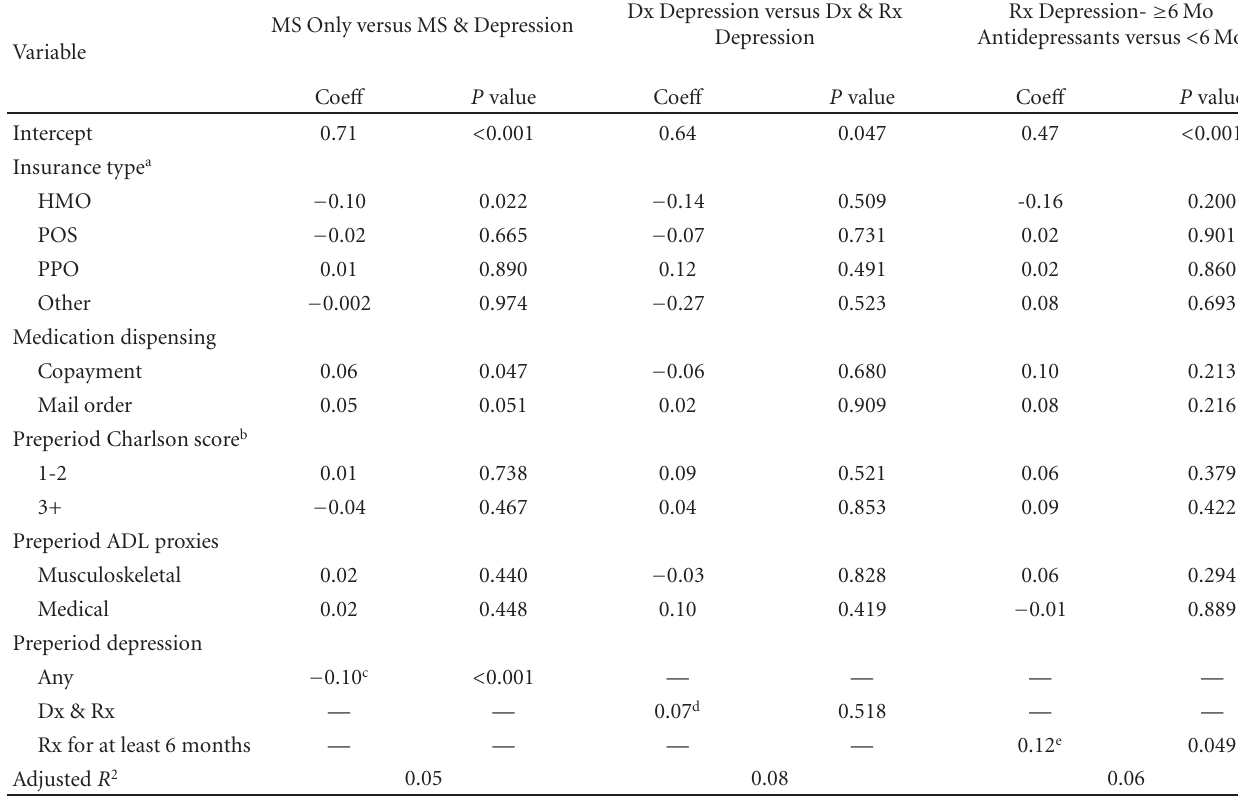
Table 4: Ordinary least squares regression results dependent variable: